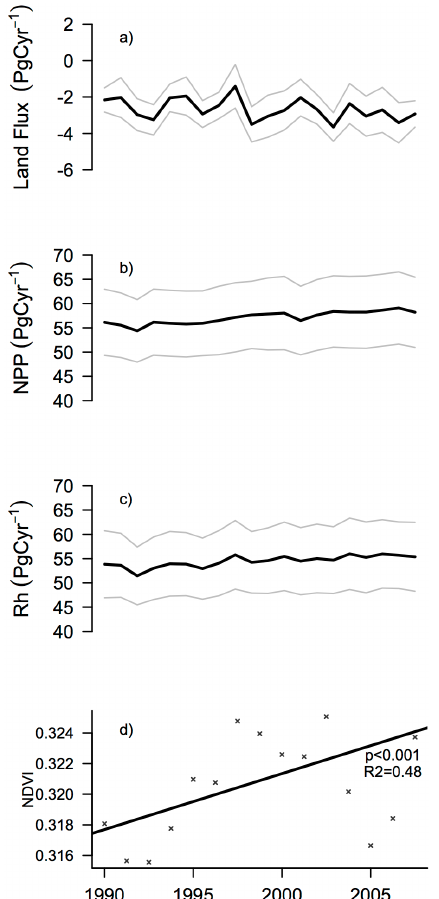
Figure 3. Global trends in ensemble land model responses. (a) DGVM mean model land to atmosphere net CO 2 flux and stan- dard deviation (grey lines); ( b ) component fluxes, NPP; and ( c ) RH ( = RH + wildfire + riverine C flux); and ( d ) remotely sensed trends in annual mean NDVI (crosses), a measure of vegetation greenness, and a linear regression through the data points (bold line).